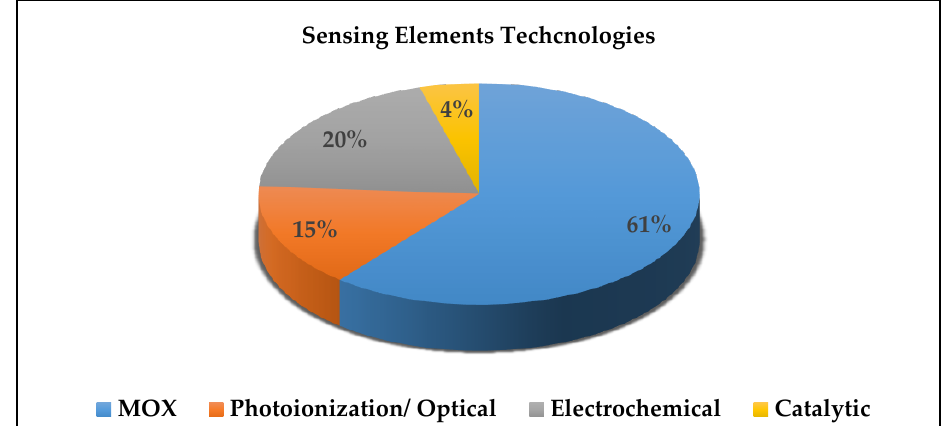
Figure 7. Distribution of the used sensing elements technologies.